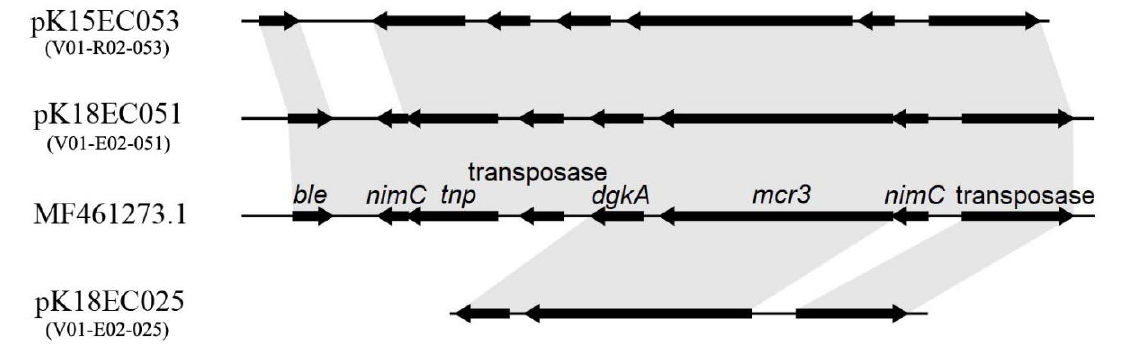
Figure 1. Comparison of the genetic environment of the mcr - 3 gene in plasmids pK18EC025, pK18EC051, and pK15EC053 with pWZR10 (MF461273.1). Arrows indicate the positions and directions of the genes. Regions with >99% homology are indicated by grey shading.